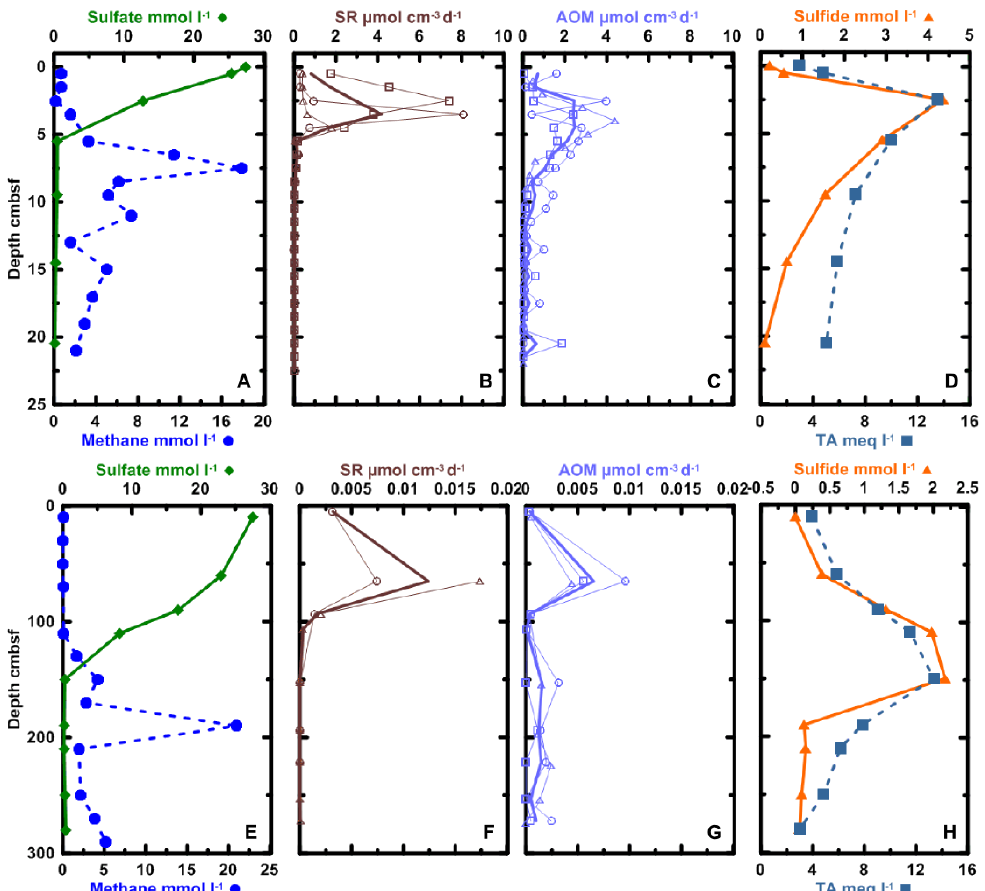
Fig. 3. Mound 11 porewater profiles for sulfate, methane, sulfide, and total alkalinity (TA) as well as rates of sulfate reduction (SR) and anaerobic oxidation of methane (AOM). (A–D) : SO206-39 (MUC) (covered by sulfur bacteria mat); (E–H) : SO206-50 (GC). For SR and AOM profiles of individual replicates (fine lines with symbols) average profiles (bold lines without symbols) are given. Note the difference in depth (cmbsf) between station SO206-50 (GC) and stations SO206-39, 44, and 46 (MUC). Table 4. Ex situ determined rates of anaerobic oxidation of methane (AOM) and sulfate reduction (SR) obtained from SO206 MUC sediment cores, in comparison with previous studies. Modelled AOM rates and benthic fluxes are also presented. All rates are expressed in mmolm − 2 d − 1 . Standard deviations (SD) are given. Depth of Precipitation Simulated